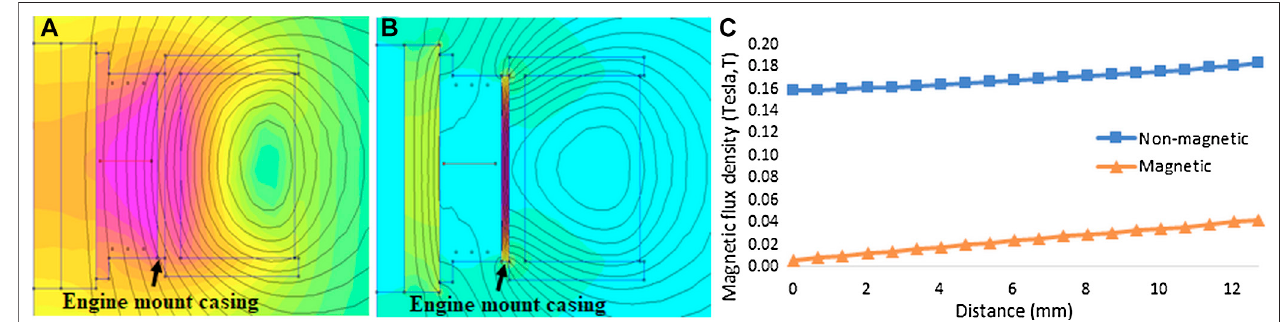
FIGURE 7 | Magnetic fl ux distribution, (A) Non-magnetic material mount casing, (B) Magnetic material mount casing, and (C) Magnetic density analysis on the mount casing material ’ s type.